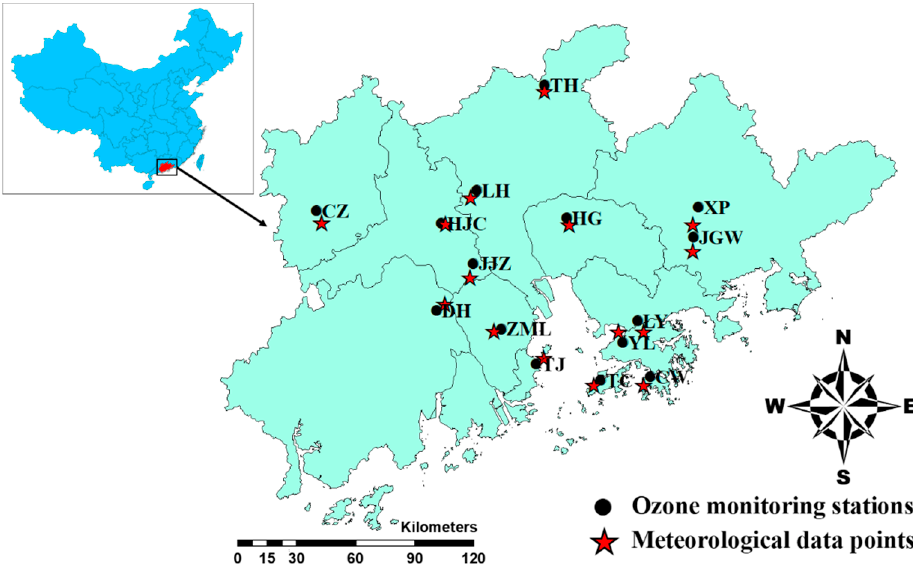
Figure 1. Distribution of O 3 monitoring stations and meteorological data points in the Pearl River Delta.